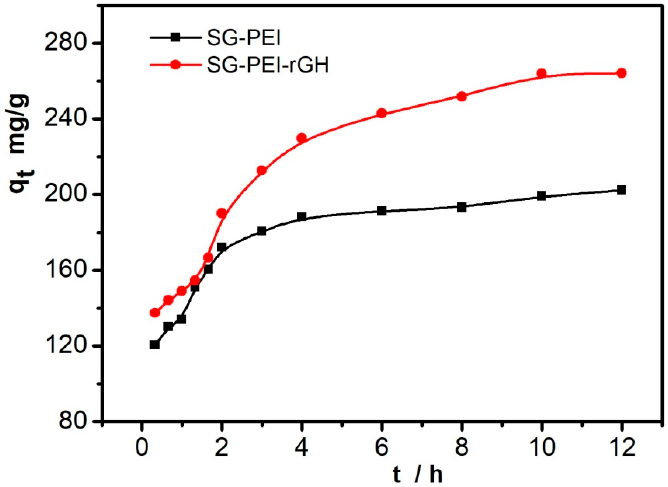
Figure 7. Kinetic sorption plot of Hg 2+ on SG-PEI and SG-PEI/rGH.